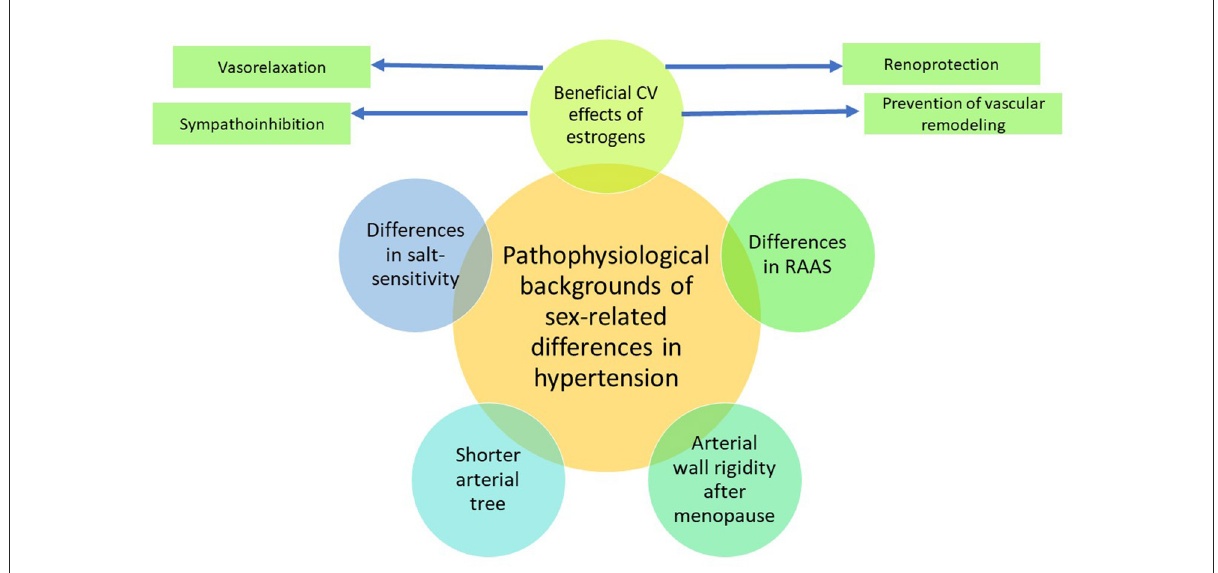
FIGURE1 Pathophysiological background of sex-related differences in hypertension. CV, cardiovascular; RAAS, renin-angiotensin-aldosterone system. Sex-related differences in hypertension are mostly explained by the beneficial action of estrogens, promoting vasorelaxation and sympathoinhibition, preventing vascular remodeling, and providing renoprotection. Estrogens also alter the balance between the vasoconstricting and vasodilating arms of the renin-angiotensin-aldosterone system, favoring vasodilation. After menopause, these beneficial effects disappear, and the arterial wall rigidity increases. Apart from that, due to a shorter stature, women have a shorter arterial tree than men, which may lead to amplification of peak systolic blood pressure by the reflected